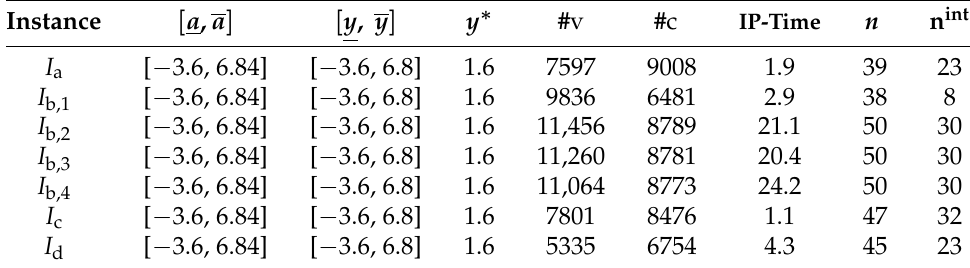
Table 11. Results of Stage 4 for L P .